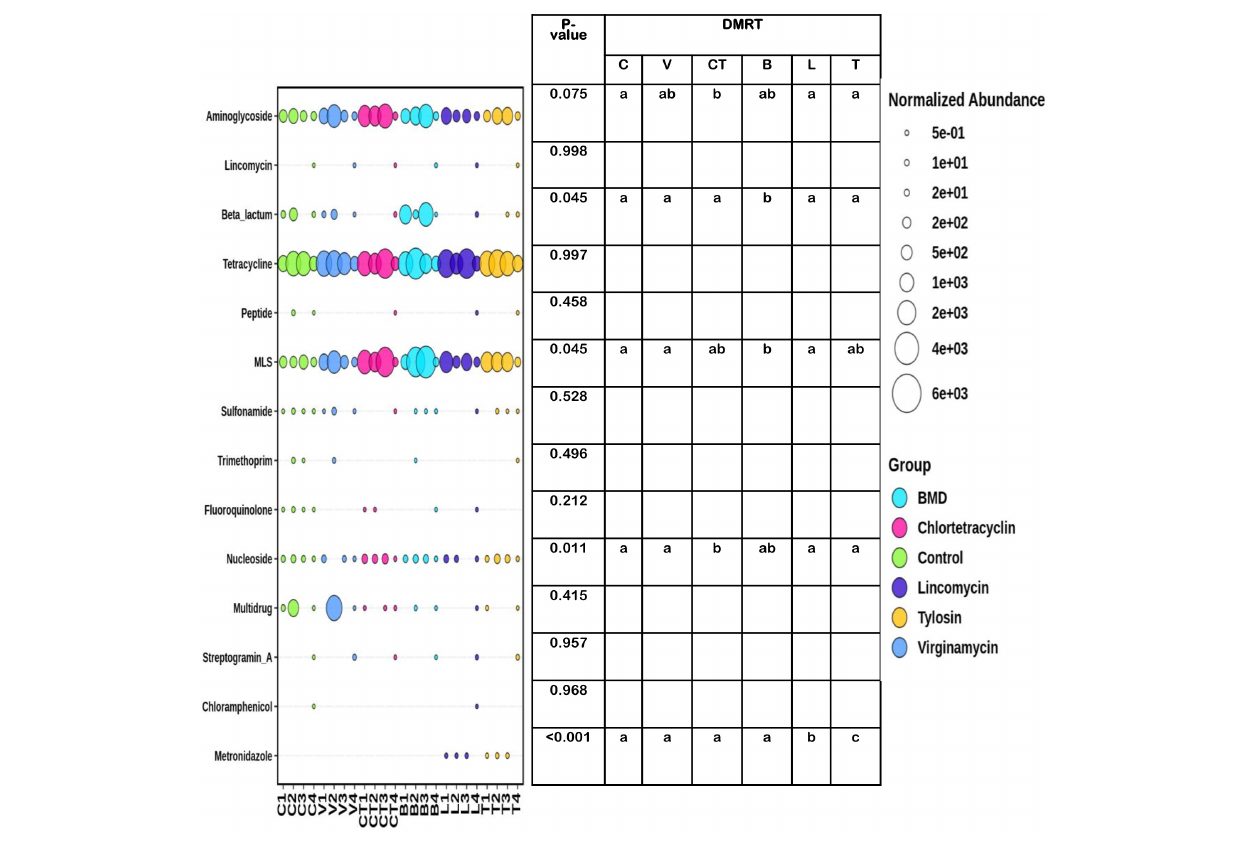
FIGURE 7 | Differential abundance of different categories of gut antimicrobial resistance genes in different experimental groups. The size of the bubbles in the bubble plot indicates the normalized (normalized to per million reads) abundance. MLS, macrolide-lincosamide-streptogramin